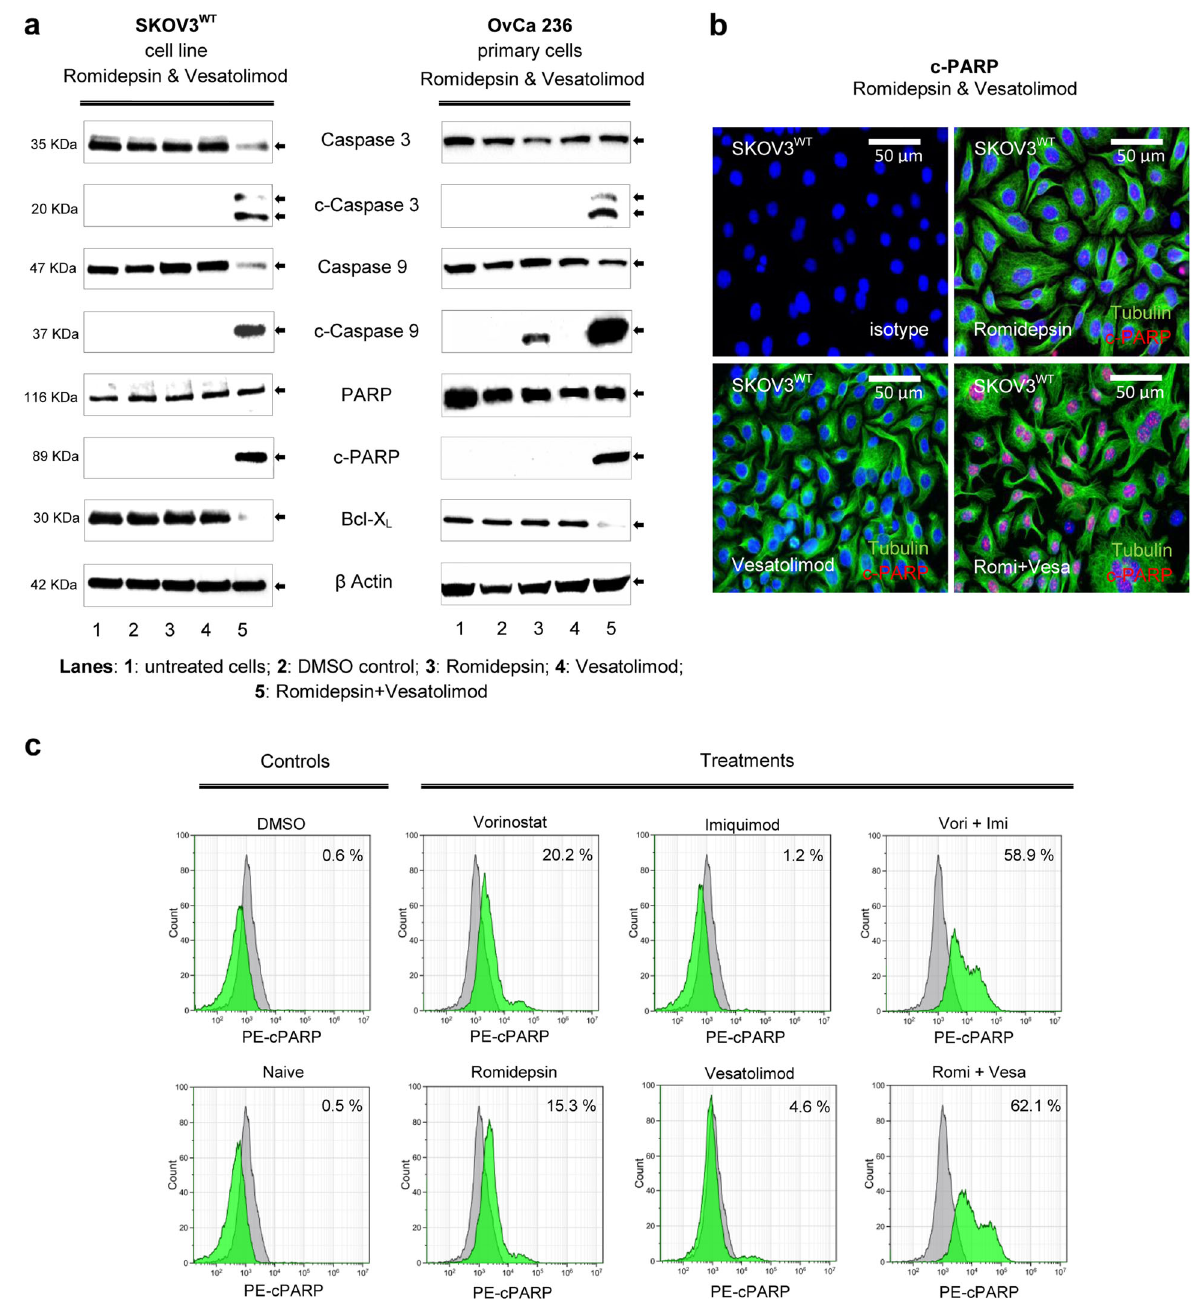
combinations for 24 h, apoptosis mediators were analysed by western blotting, revealing the cleavage of central apoptosis pathway mediators such as caspase 3 and caspase 9, the latter being a determinant for the intrinsic pathway. In congruence, the speci fi c cleavage of PARP after HTCT underlines the speci fi city of the interaction of the two substance groups. The anti-apoptotic protein Bcl-xL is downregulated by HTCT but not by the individual drugs. b c- PARP is predominantly detected (ICC) in SKOV3 WT cells incubated with romidepsin and vesatolimod combined but not with vesatolimod alone (0.5× IC 50 ). Magni fi cation ×40. c FACS analysis for cleaved PARP shows that apoptosis is triggered by HTCT but not by the individual drugs. Isotype: grey and sample: green. Results are representative of n ≥ 3